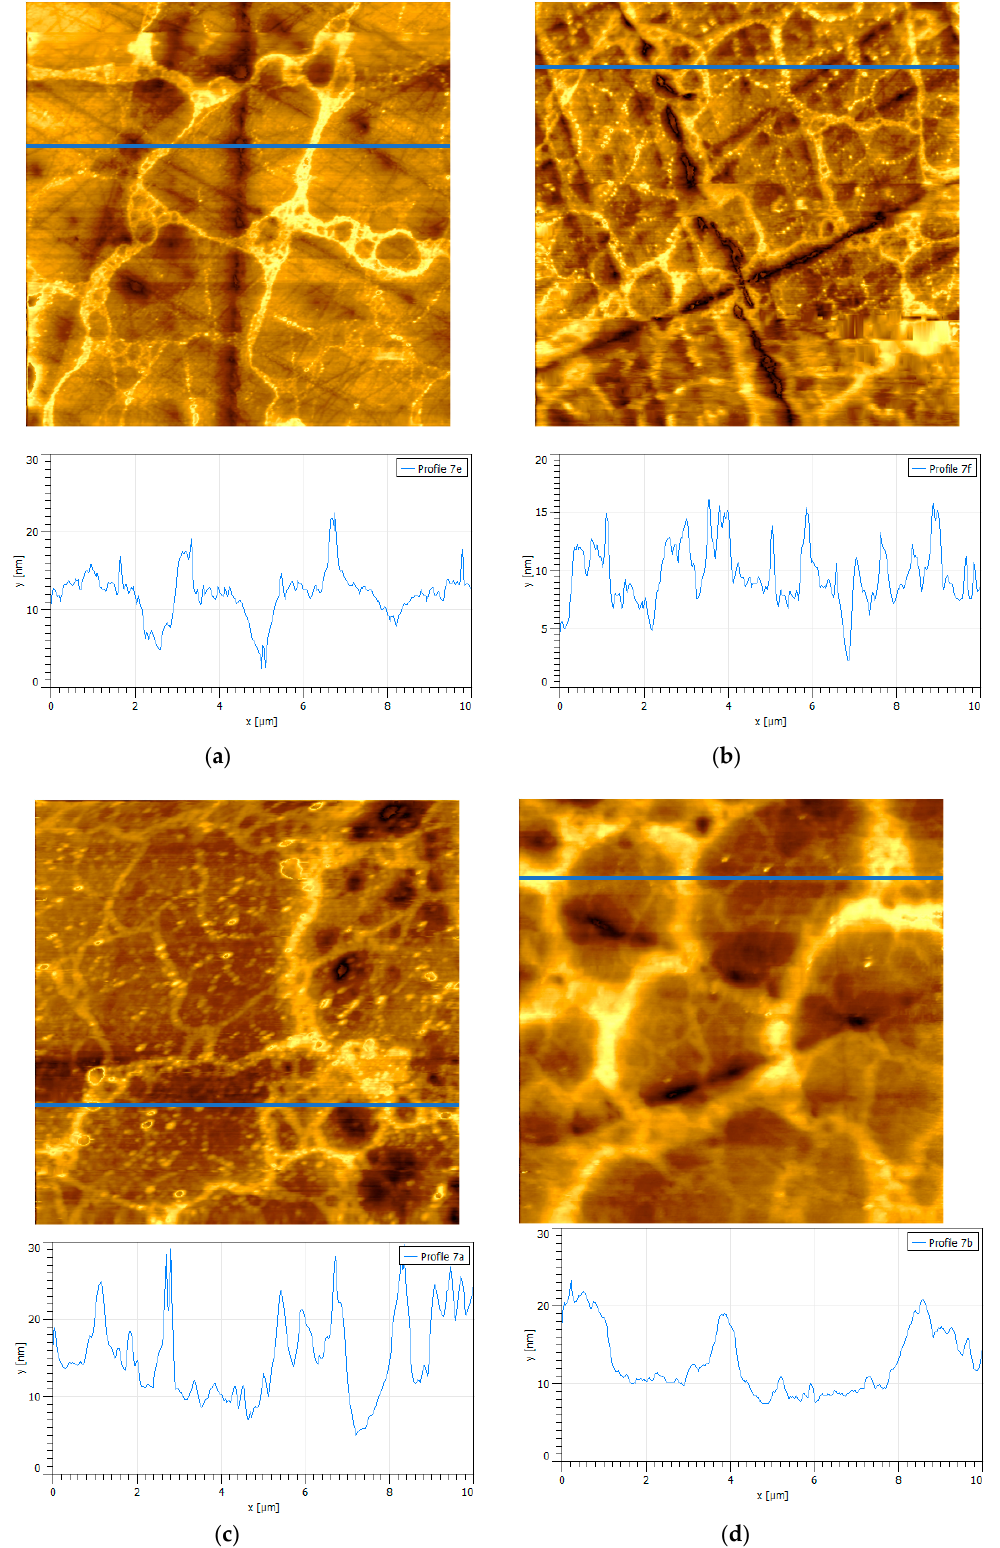
Figure 5. Surfaces {100} of oxidized pyrite exposed to PAX and sodium chloride at pH 8.5, scan size is 10 × 10 μ m 2 , and corresponding height profiles (blue lines in the images). ( a ) 0.01 M NaCl, 10 − 4 M PAX; ( b ) 0.5 M NaCl, 10 − 4 M PAX; ( c ) 0.01 M NaCl, 10 − 3 M PAX; ( d ) 0.5 M NaCl, 10 − 3 M PAX.